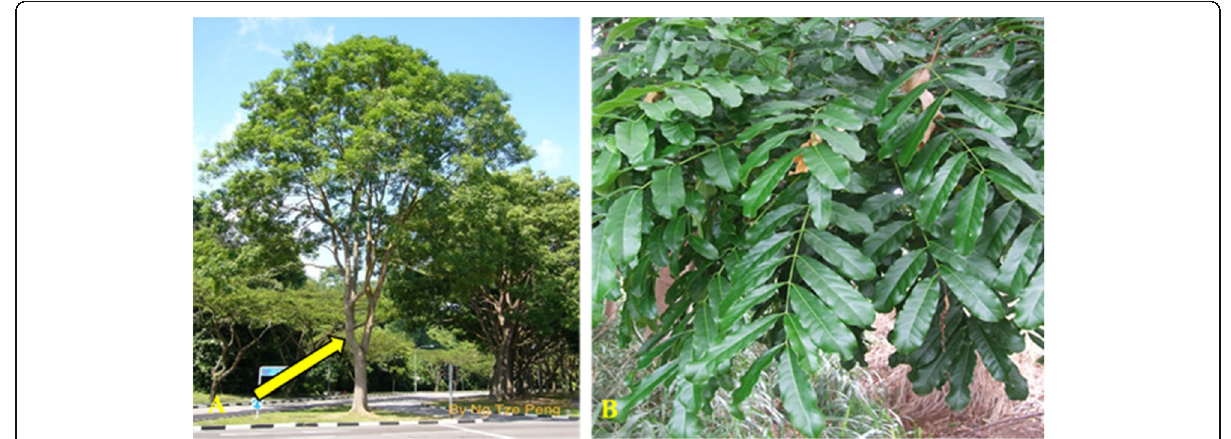
Fig. 5 K . senegalensis . a Tree. b Leaves. Source: Google